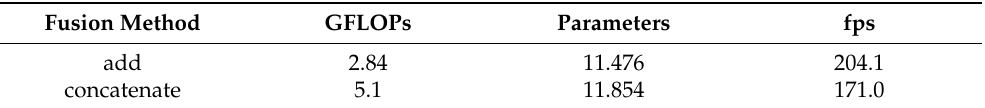
Table 7. Experimental results of information fusion on model inference speed using concatenate and aggregation.